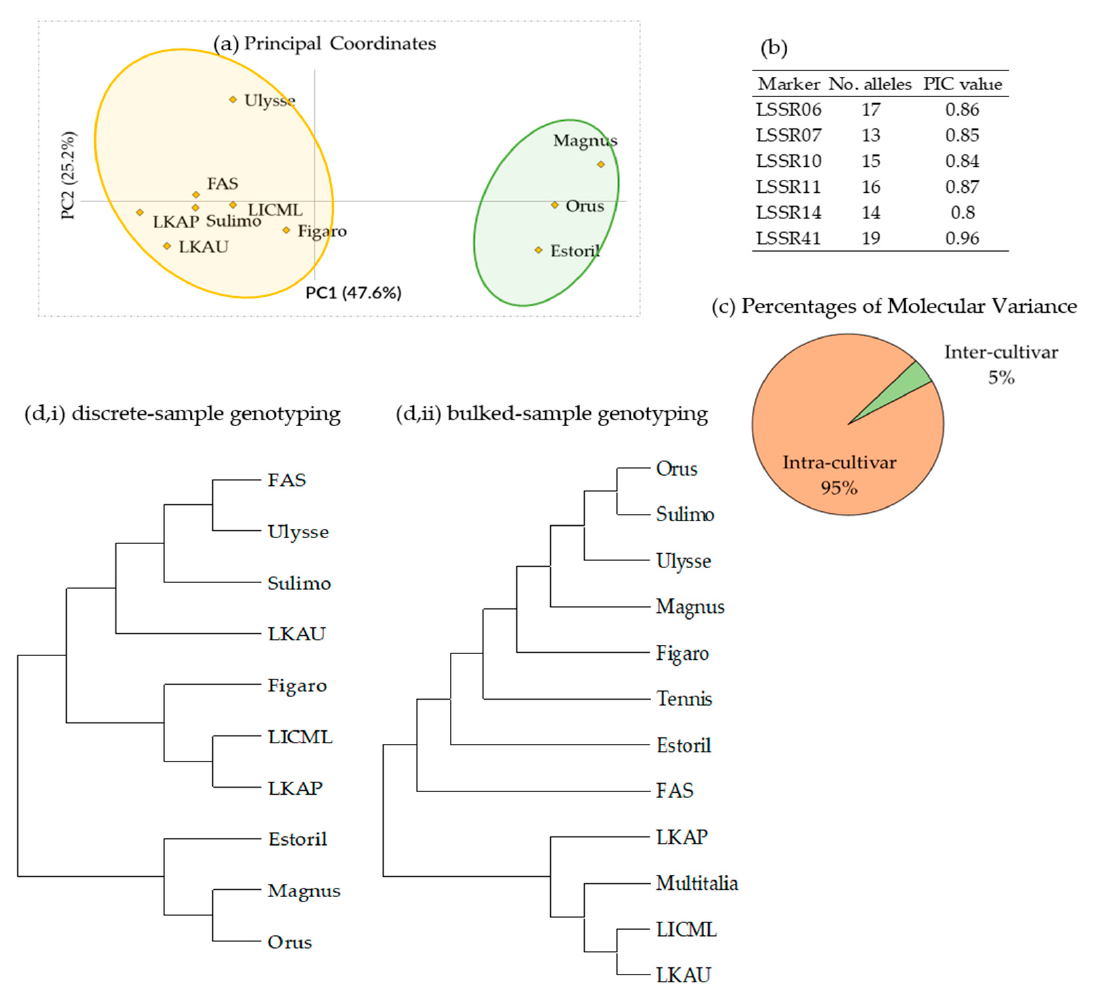
Figure 2. ( a ) Principal coordinates analysis of the molecular genetic diversity observed among 10 L. albus cultivars, where the first two coordinates explain 72.8% of the total variability; ( b ) polymorphic information content of the 6 SSRs used in the study; ( c ) AMOVA pie plot where 95% of the observed variability is assigned within each cultivar ( p < 0.001); ( d ) comparison of the genetic relationships of the accessions, based on genotyping of ( i ) individual and ( ii ) re-analyzed bulked samples.